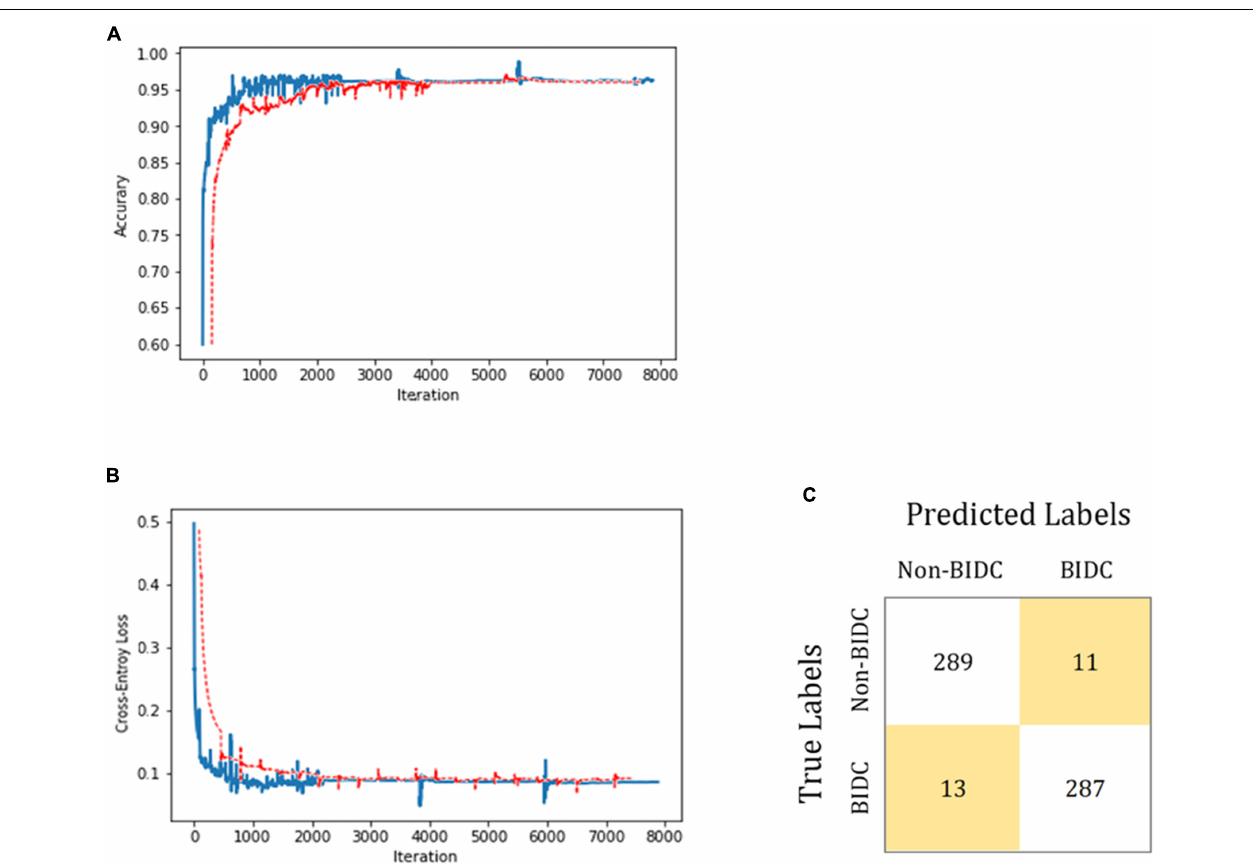
FIGURE 5 | BIDC diagnosis transfer-learning performance using breast tissue microscope slide images. In (A,B) , the training and test datasets are shown in blue and red, respectively. The classification accuracy is plotted against training epochs, and in (B) , the categorical cross-entropy loss is shown as a function of training epochs for the binary classification problem. The curve is smoothed. (C) Shows the model-classification confusion matrix for test image classification. As shown, the proposed model successfully classifies BIDC from non-BIDC